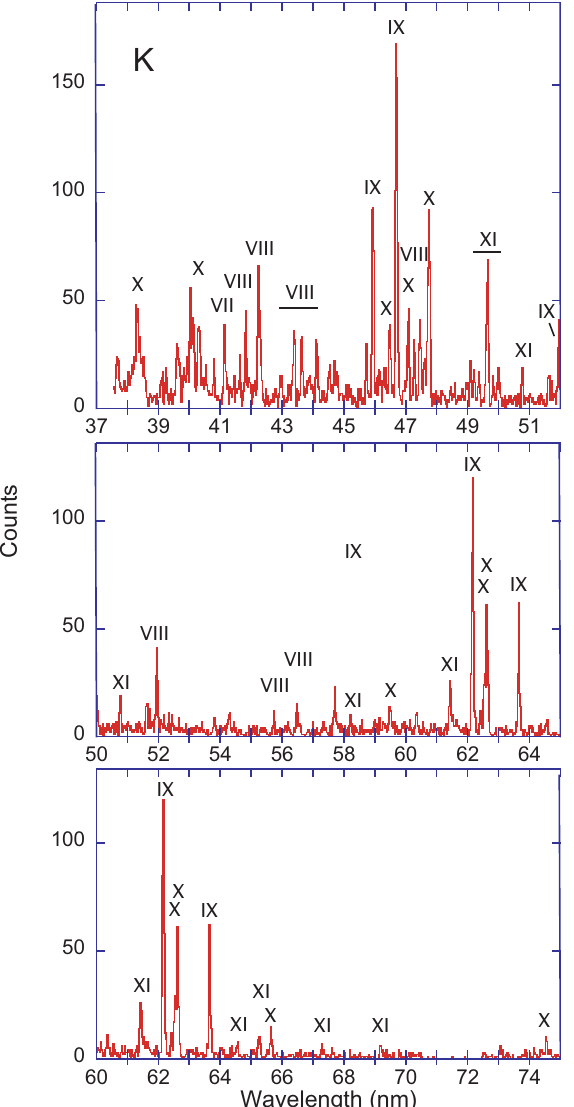
Figure 6. Spectrum of K at an ion beam energy of 12.8MeV. Line width 0.06nm. Identified spectral features are marked by the spectrum